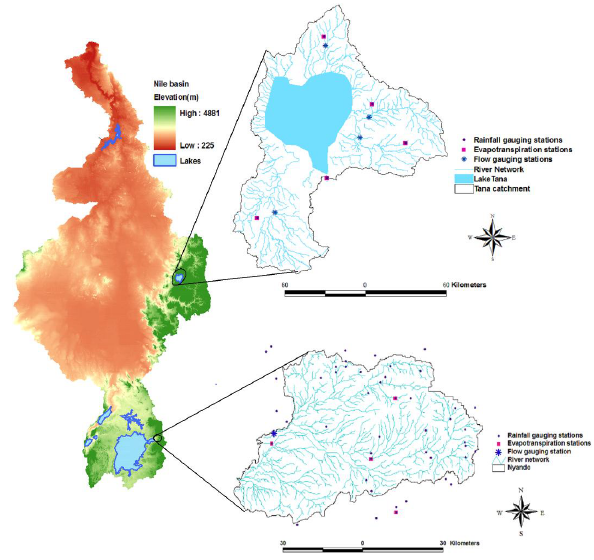
Figure 1: The Nile basin (left) and meteorological and flow gauging stations in Lake Tana catchment (top, right) and Nyando catchment (bottom, right)